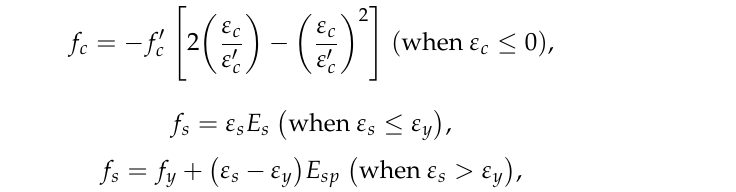
Figure 8. Shear contribution of each element.